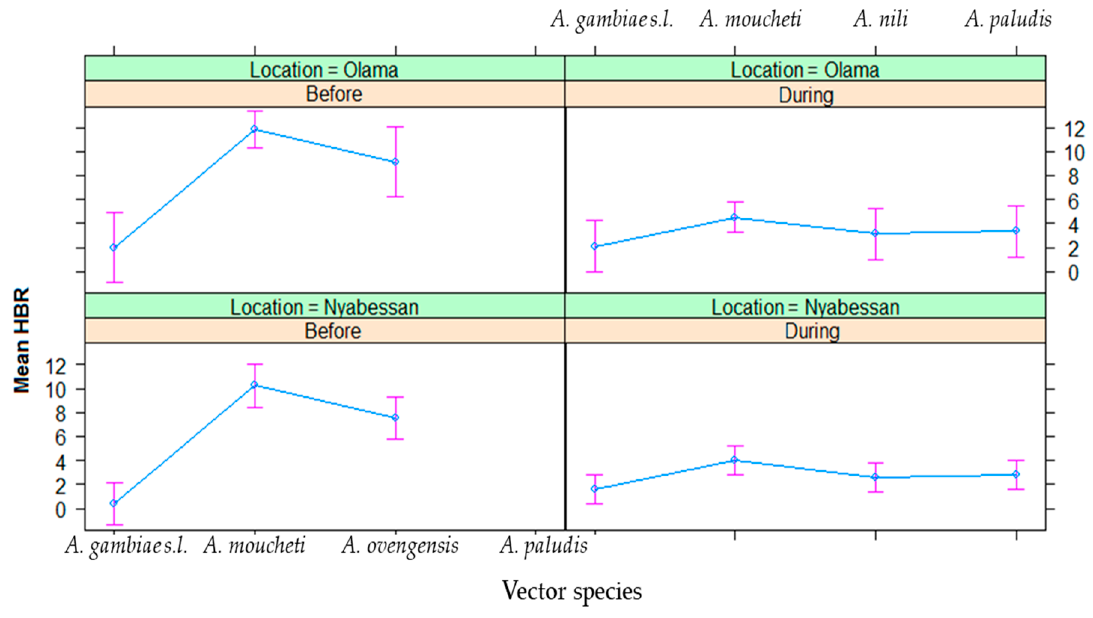
Figure 4. Effect plot showing the estimated mean HBRs in Olama and Nyabessan before and after dam construction. dam